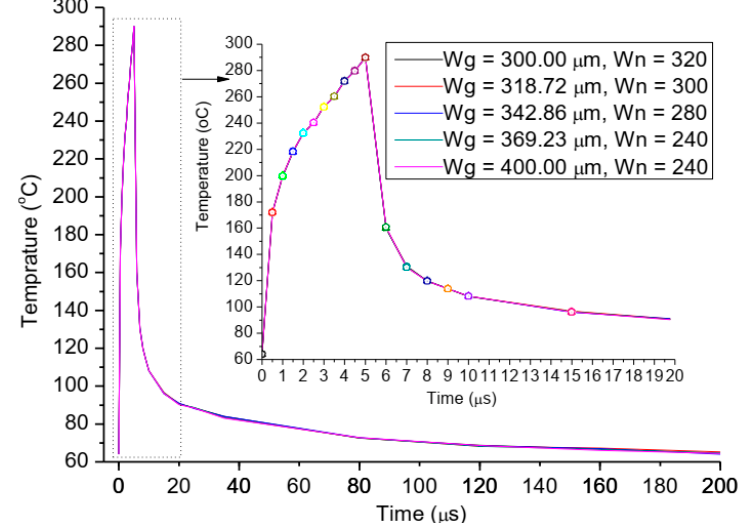
Figure 6. The relationships between transient channel temperature and the changes of the gate width and gate fingers, Wg is the width of a single gate, and Wn is the numbers of gate fingers.